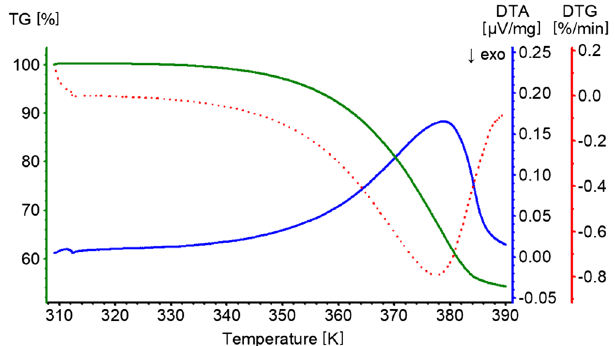
Figure 6. TG, DTA, and DTG (derivative thermogravimetric) curves of struvite heated with a heating rate of 0.4 K/min in an open crucible.